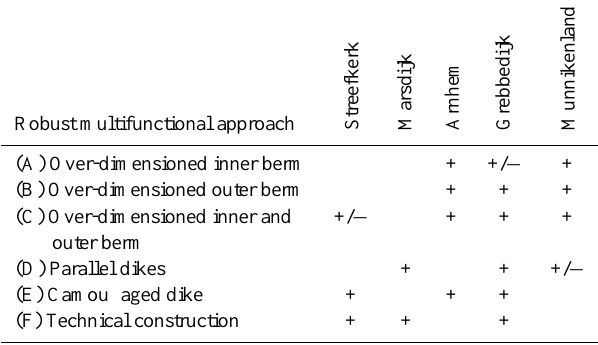
Table 9. Opinions of interviewed stakeholders on how to deal with climate change concerning dike reinforcement (+=share this view, 0=share this view more or